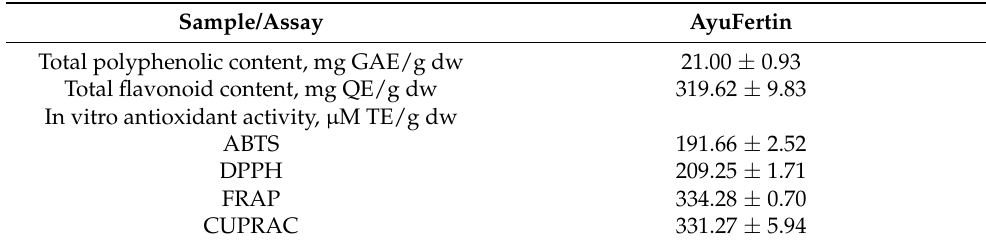
Table 2. Total polyphenolic content (TPC, mg GAE/g dw), total flavonoid content (TFC, mg QE/g